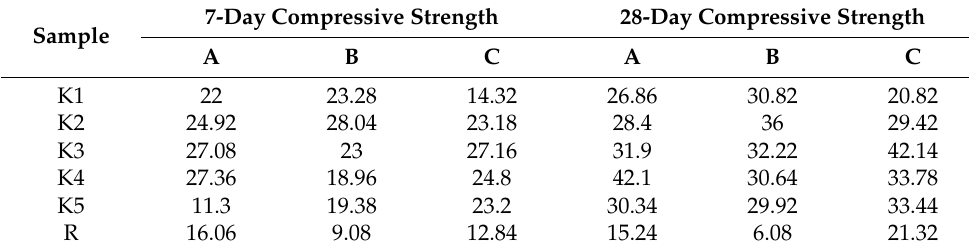
Table 6. Range analysis of compressive strength results.